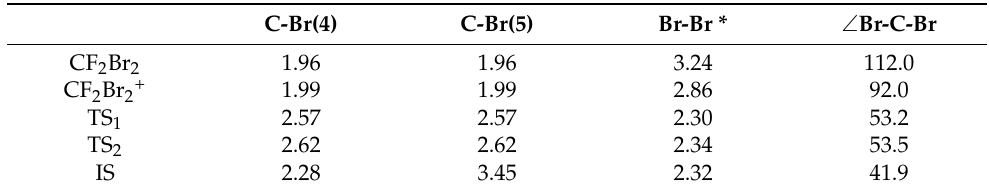
Table 3. The bond lengths of the two C-Br bonds, the distance of the two Br atoms and bond angle of ∠ Br-C-Br for the related